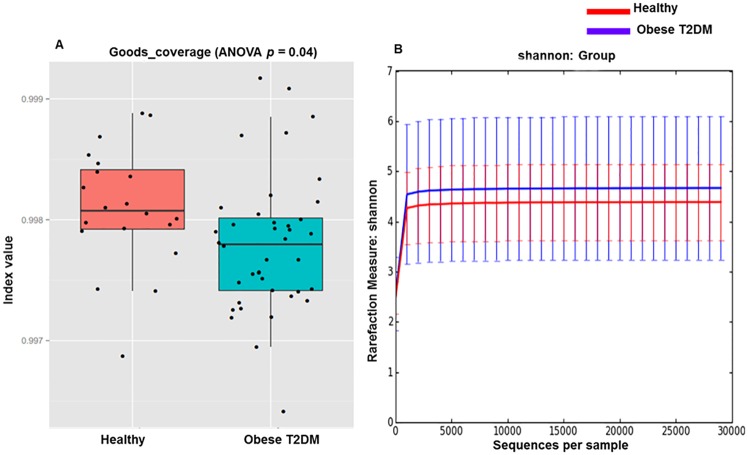
Alpha diversity between obese-T2DM patients.(A) Comparison of Boxplots depicting OTU/Diversity between obese-T2DM patients (n = 40) and healthy participants (n = 20). (B) The Shannon Wiener index representing the number of species and uniformity of individual distribution between obese-T2DM patients (n = 40) and healthy participants (n = 20).